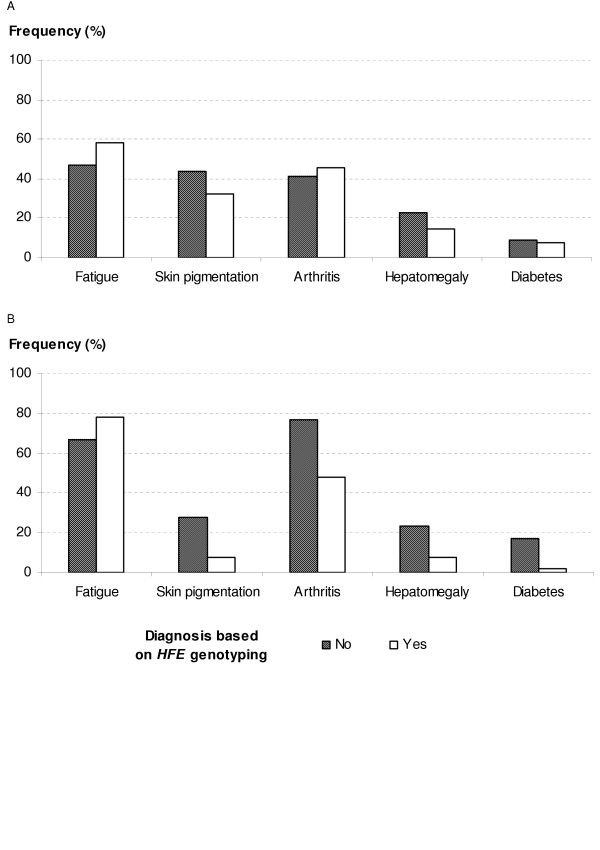
(A) Frequency of the main clinical signs and symptoms at the time of diagnosis in males, before and after the implementation of the genetic test. (B) Frequency of the main clinical signs and symptoms at the time of diagnosis in females, before and after the implementation of the genetic test